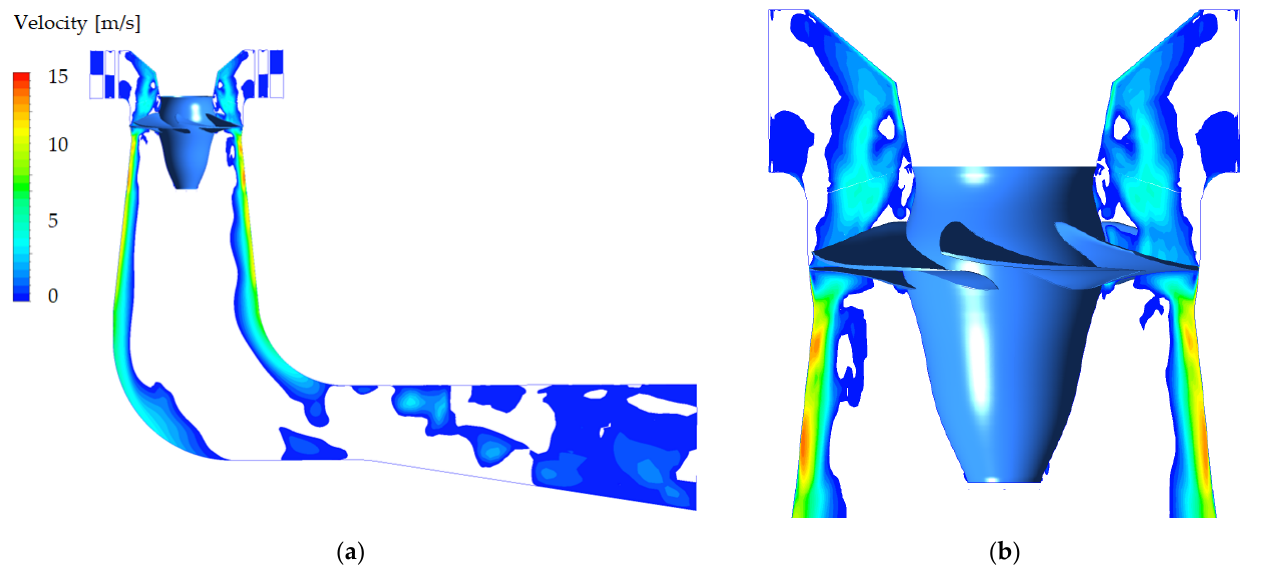
Figure 20. Streamlines coming from (blue) and to (red) the runner blades. 5. Conclusions The present paper introduces the numerical investigation of the flow in a full-scale 10 MW Kaplan turbine prototype operated at SNL. A numerical model was developed starting from the scaled geometry of the turbine model, and potential simplifications that can optimize the numerical accuracy and computational costs were explored. The